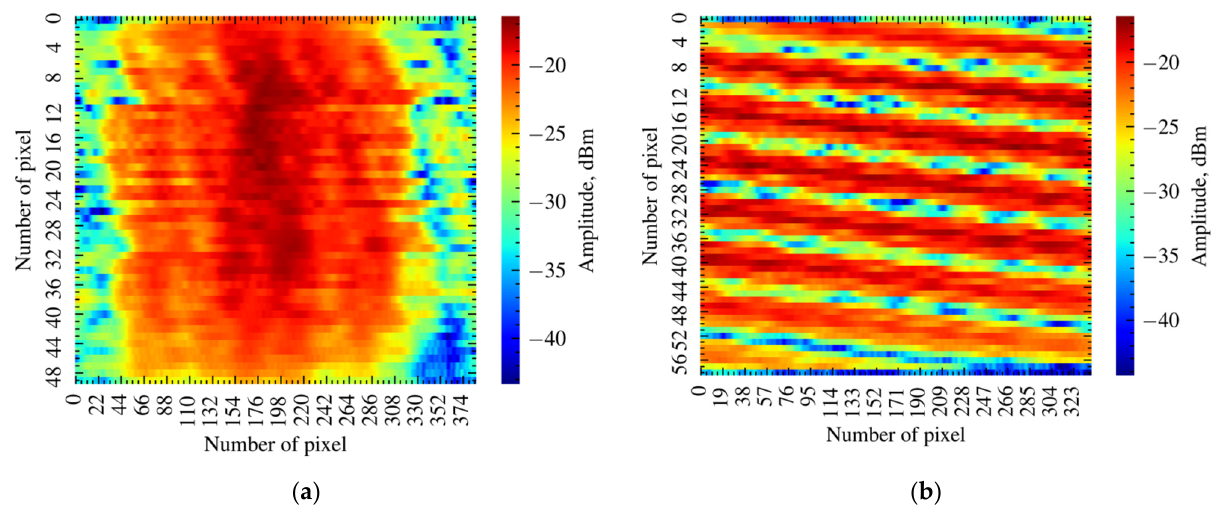
Figure 7 . ( a ) 2D reflectance spectrum of FBG sensor with centered reflectance peaks; ( b ) 2D reflectance pattern of FBG obtained by slicing the reflectance spectrum into 59 pieces.